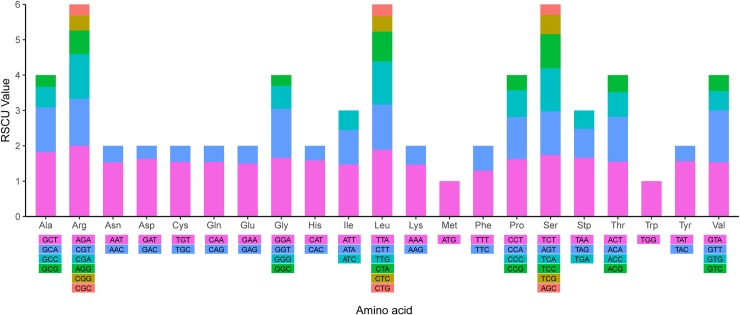
Codon content of 20 amino acids and stop codons in all protein-coding genes of the A. oxyphylla chloroplast genome.The colour of the histogram corresponds to the colour of codons.